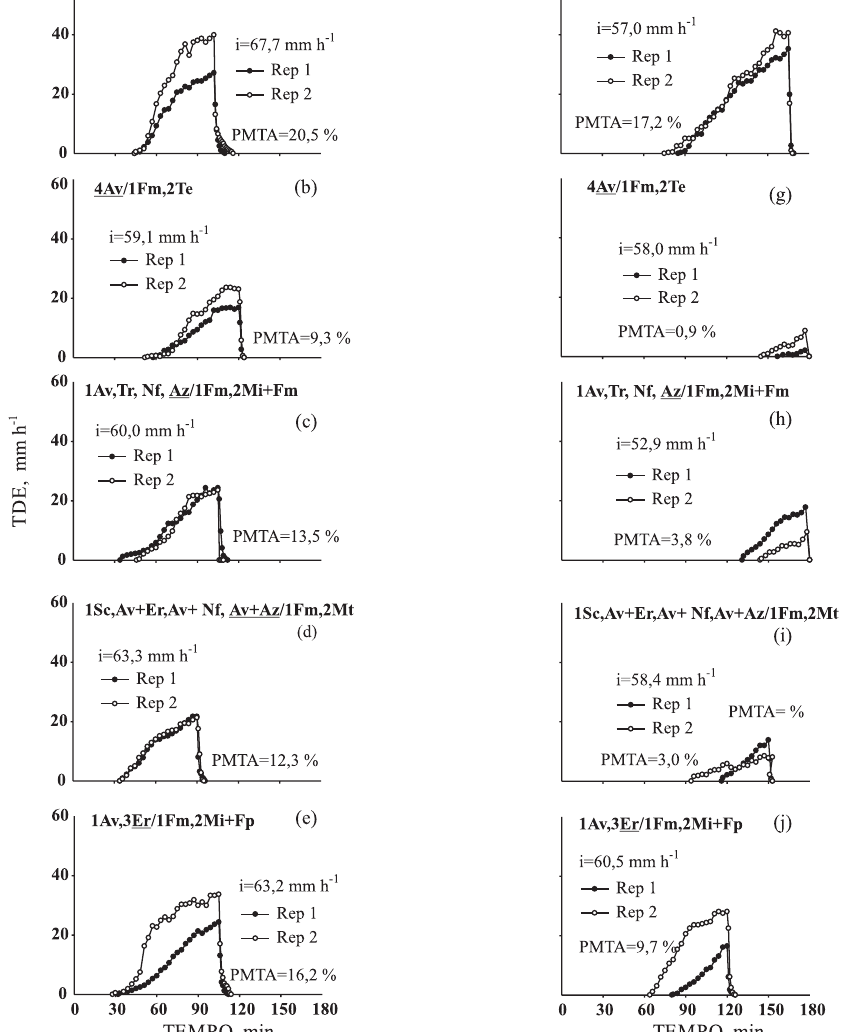
Figura 3. Taxas instantâneas de descarga da enxurrada (TDE) no quinto (T5: solo previamente escarificado – em T4 -, raízes mortas, 18 % coberto – figuras (a) a (e), à esquerda) e no sexto (T6: solo recém-gradeado – após T5 -, raízes mortas, 0 % coberto – figuras (f) a (j), à direita) teste de erosão com chuva